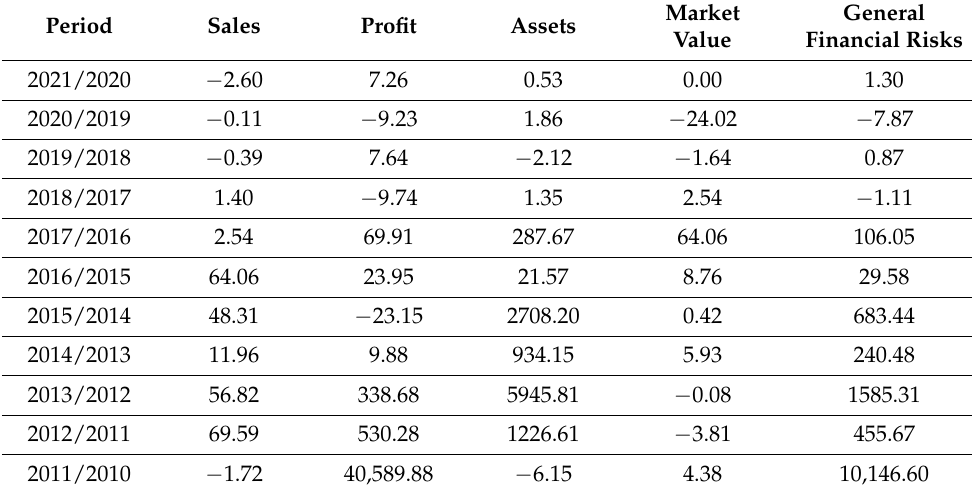
Table 1. Dynamics of financial risks (FR) in 2010–2021. Period Sales Profit Assets